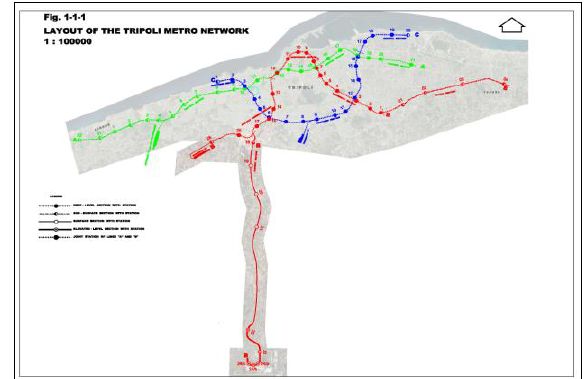
Figure 2. Planned layout of Tripoli Metro Network